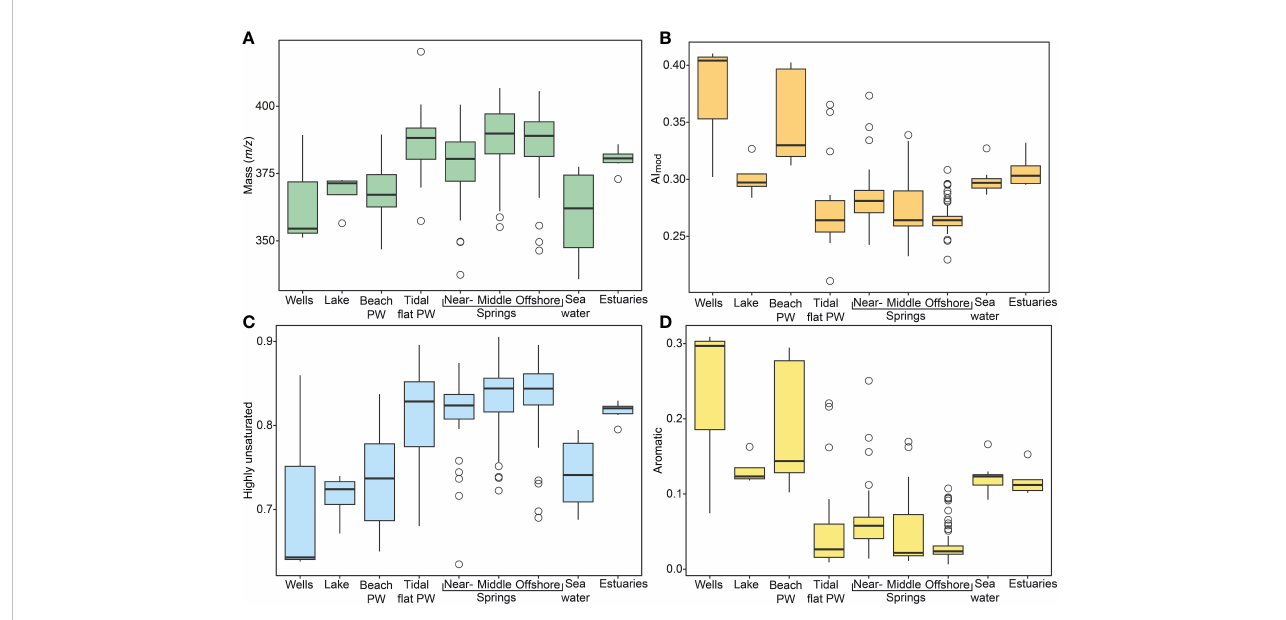
FIGURE 3 DOM molecular data for Sahlenburg tidal fl at endmembers. (A) m/z , (B) AI mod , (C) intensity-weighted relative abundance of highly unsaturated compounds, and (D) aromatic compounds. PW,